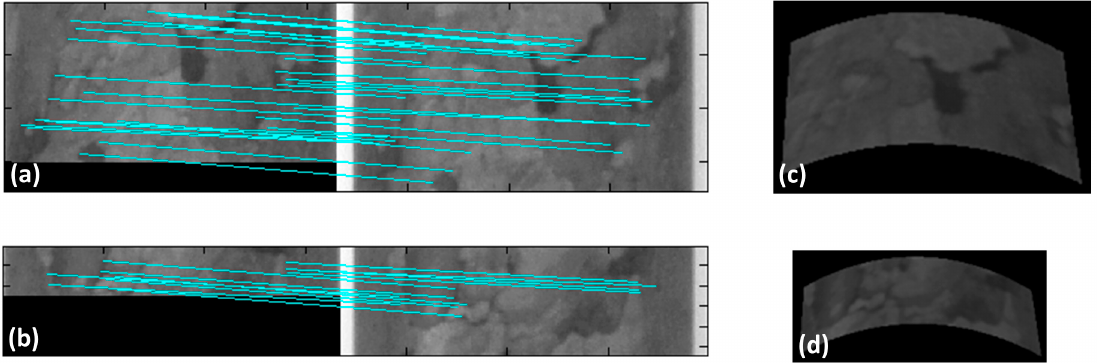
Table 3. Parameters of the geometric transformation estimated by least squares adjustment in two image patches.